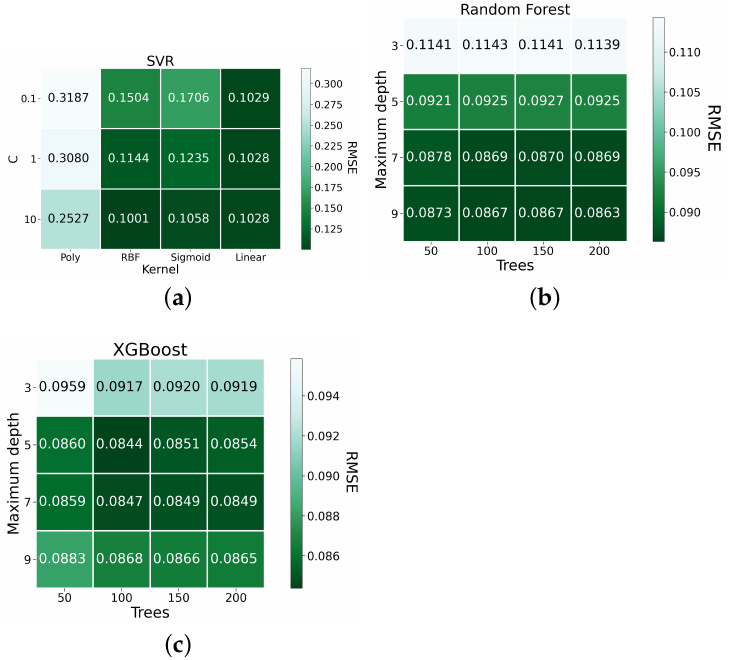
Figure 2. RMSE grid search result for ( a ) SVR; ( b ) Random Forest; and ( c )